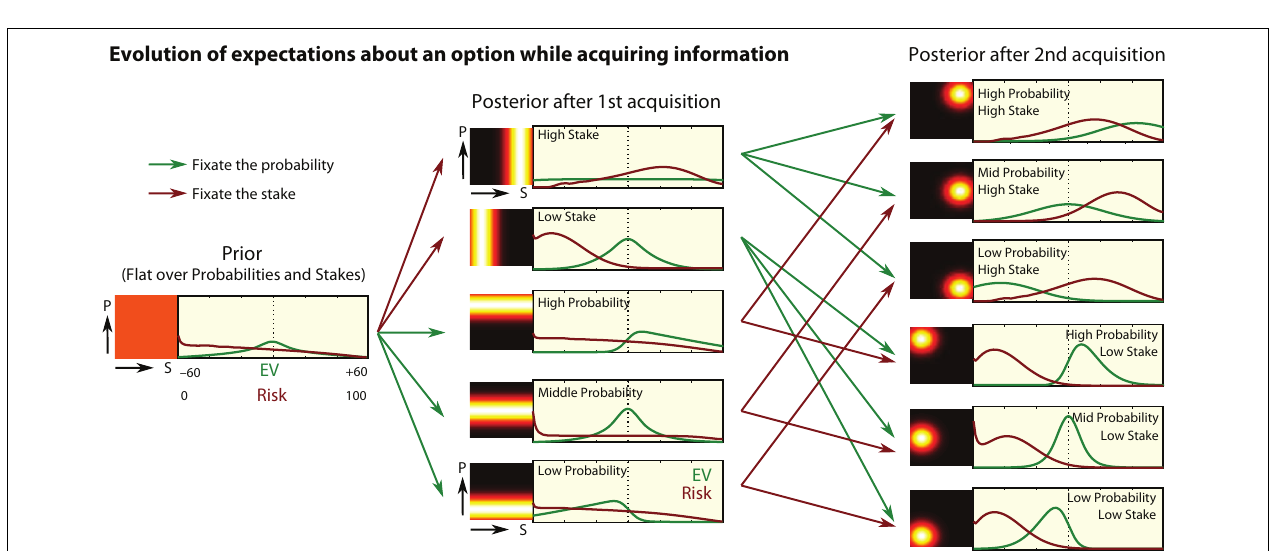
FIGURE 7 | Bayesian updating of expectations. What information is obtained in the first two acquisitions? Heatmaps on the left of each panel illustrate the participant’s estimated distribution of probability and stake. From this we calculate the estimated distribution of EV s and Risks Equations (6) and (7). Far left: the priors give a relatively flat distribution for EV and risk. First column: after the first